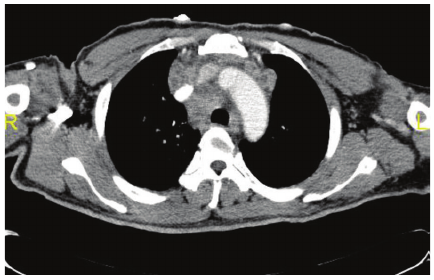
Figure 5: Computed tomography of chest showing mediastinal adenopathy with peripheral enhancement and central necrotic